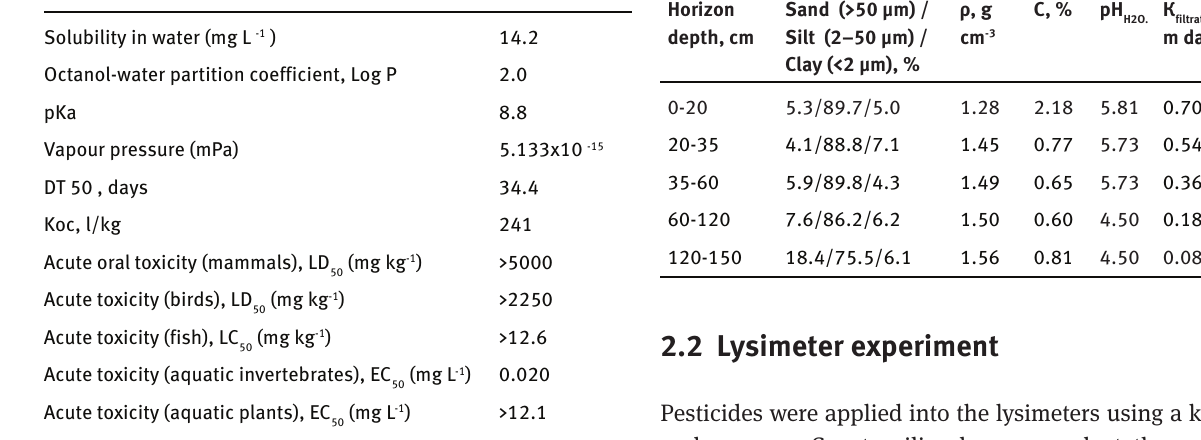
Table 2: Some physical and chemical properties of the